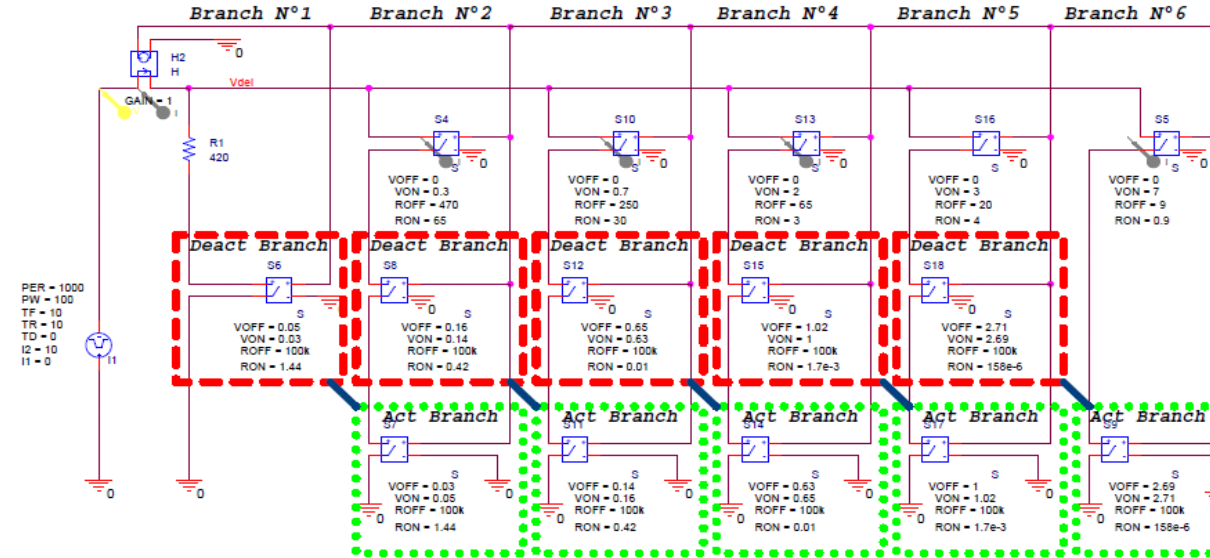
Figure 20: Parallel “Switch” model proposal